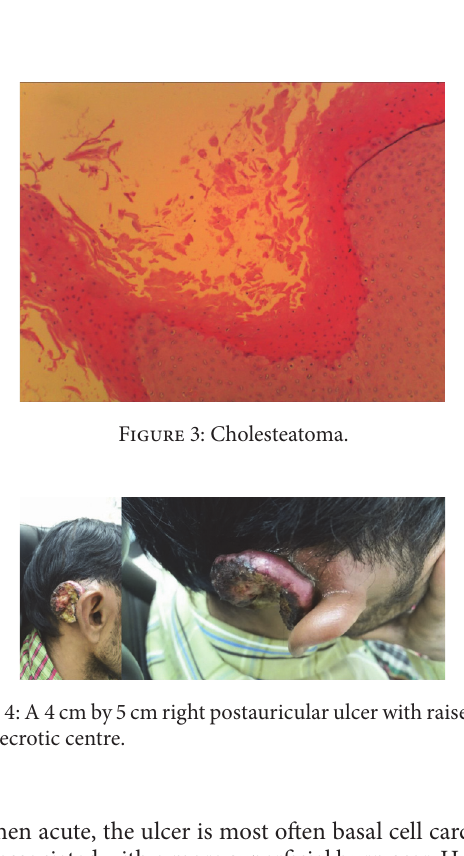
Figure 2: MRI of the brain, IAC, and mastoid with IV contrast. Axial and coronal views show (a) MRI T1 axial view before contrast, (b, c) MRI T1 axial view after contrast, and (d) MRI T1 coronal view after contrast. Right, large, loculated, peripheral enhancing collection is observed in the subcutaneous tissue of the auricular region, posterior and anterosuperior to the external auditory canal and extending to the mastoid air cells and middle ear cavity. The cochlea and semicircular canals are not visualized; only part of the vestibule is observed, and a focal area of dural enhancement is observed in the right temporal lobe.